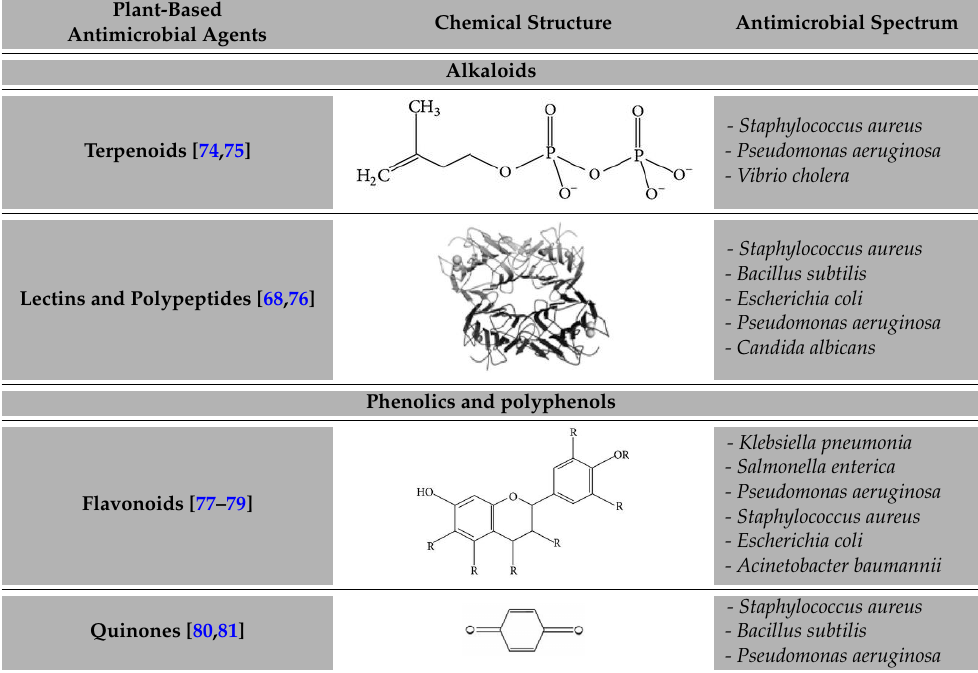
Table 3. Different plant-based compounds’ chemical structure and respective antimicrobial spectrum.